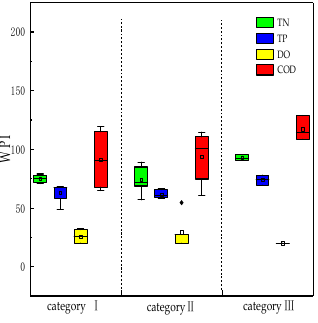
Figure 12. Box and whisker plots of spatial variation in the wet season.